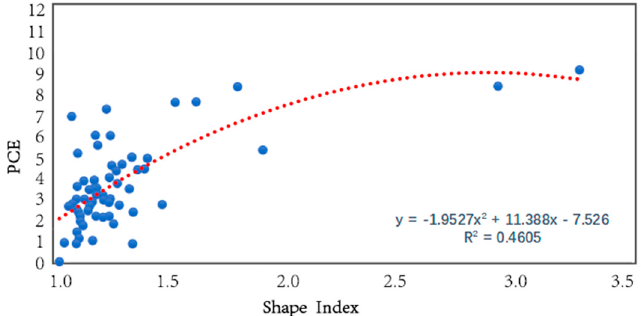
Figure 10. Shape index and cooling efficiency fitting curve.